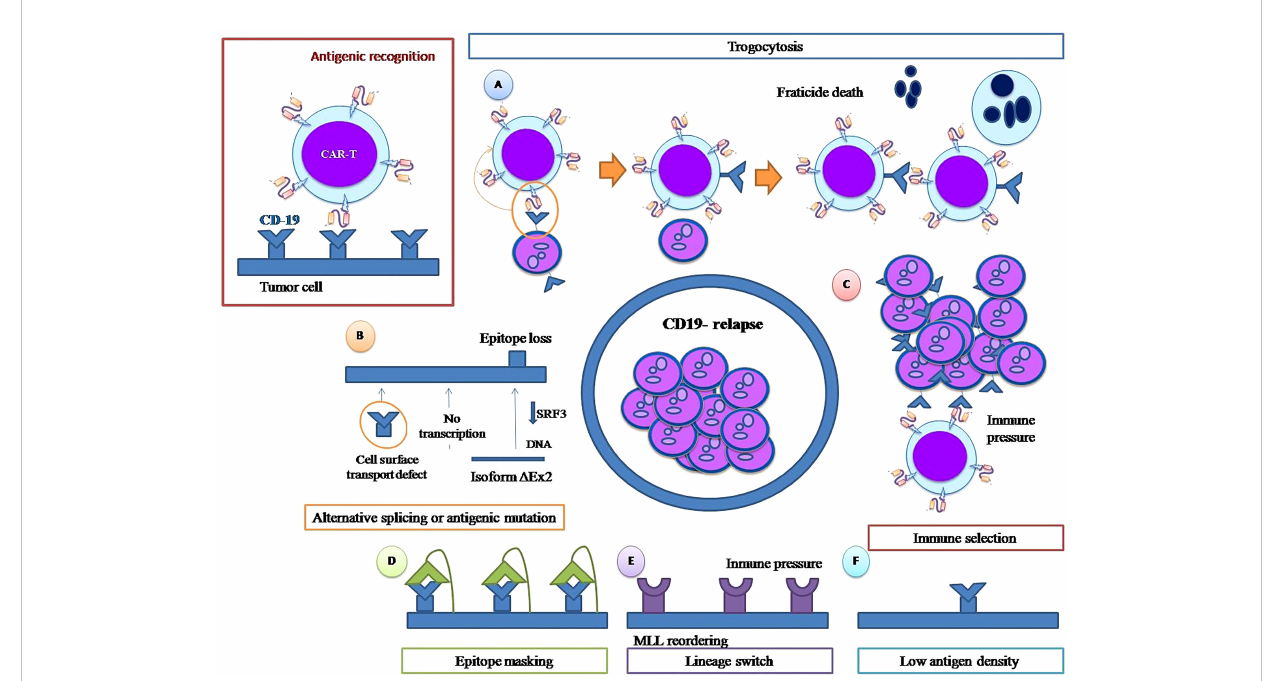
FIGURE 1 CD 19 negative relapse mechanisms. Trogocytosis and fratricide (A) . Alternative splicing or antigenic mutation (B) Immune pressure (C) . Epitope masking (D) Lineage switch (E) . Low antigen density (F)